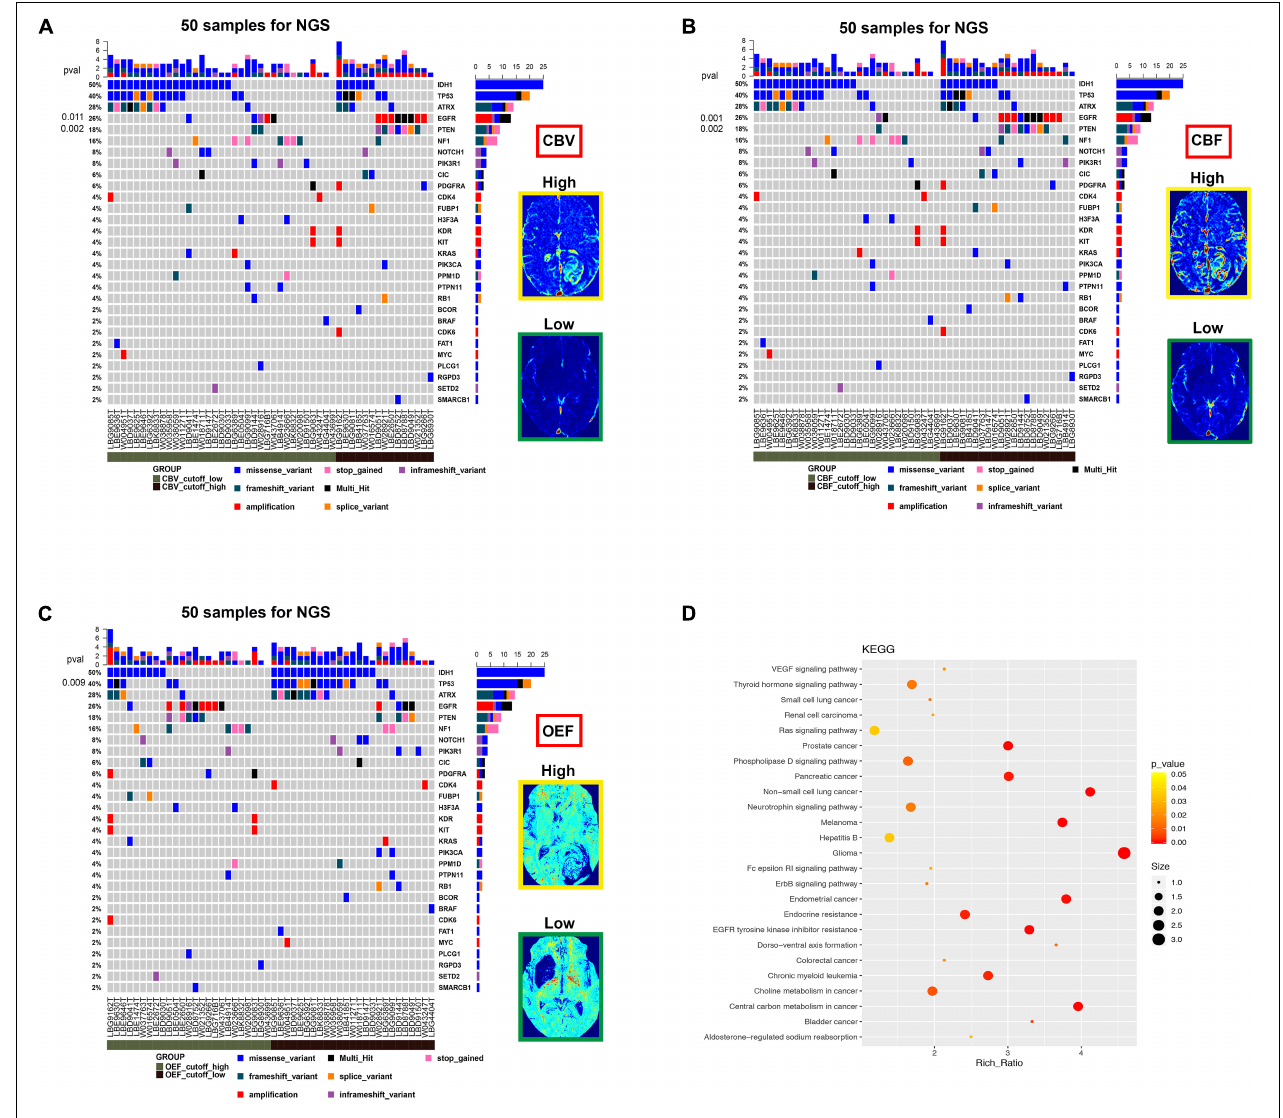
FIGURE 5 | The mutational landscape and biological signatures for 50 tumor samples with NGS, 49 of which harbored genetic alterations. (A–C) Samples from patients have been stratified according to the cutoff value of imaging parameters (CBV, CBF, and OEF) for RTK aberrations. The heat map below displays the somatic mutated genes ordered by their respective mutation frequencies. The significant genes with a p -value < 0.05 were labeled on the left. (D) Kyoto Encyclopedia of Genes and Genomes pathway analysis enriched in the RTK